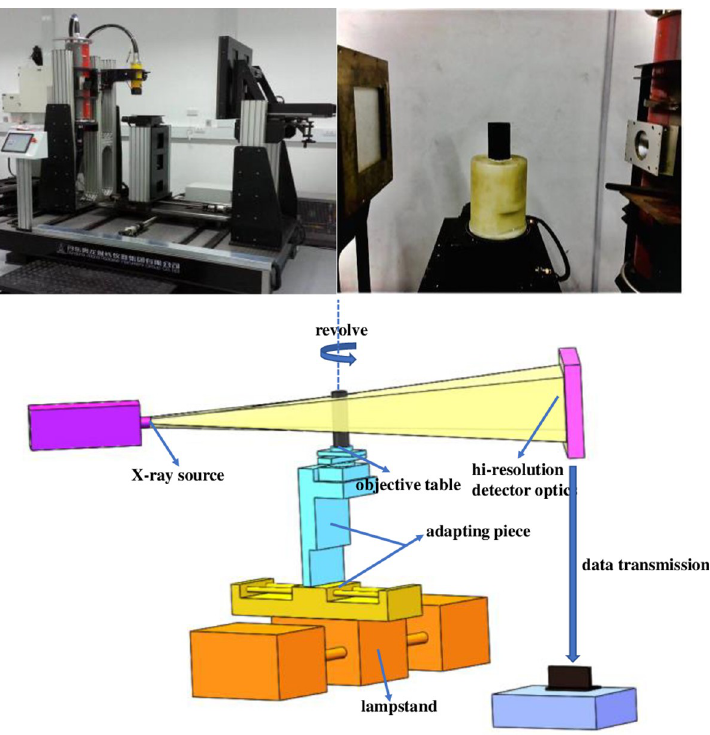
Fig 2. AL-CT-225 type CT scanning